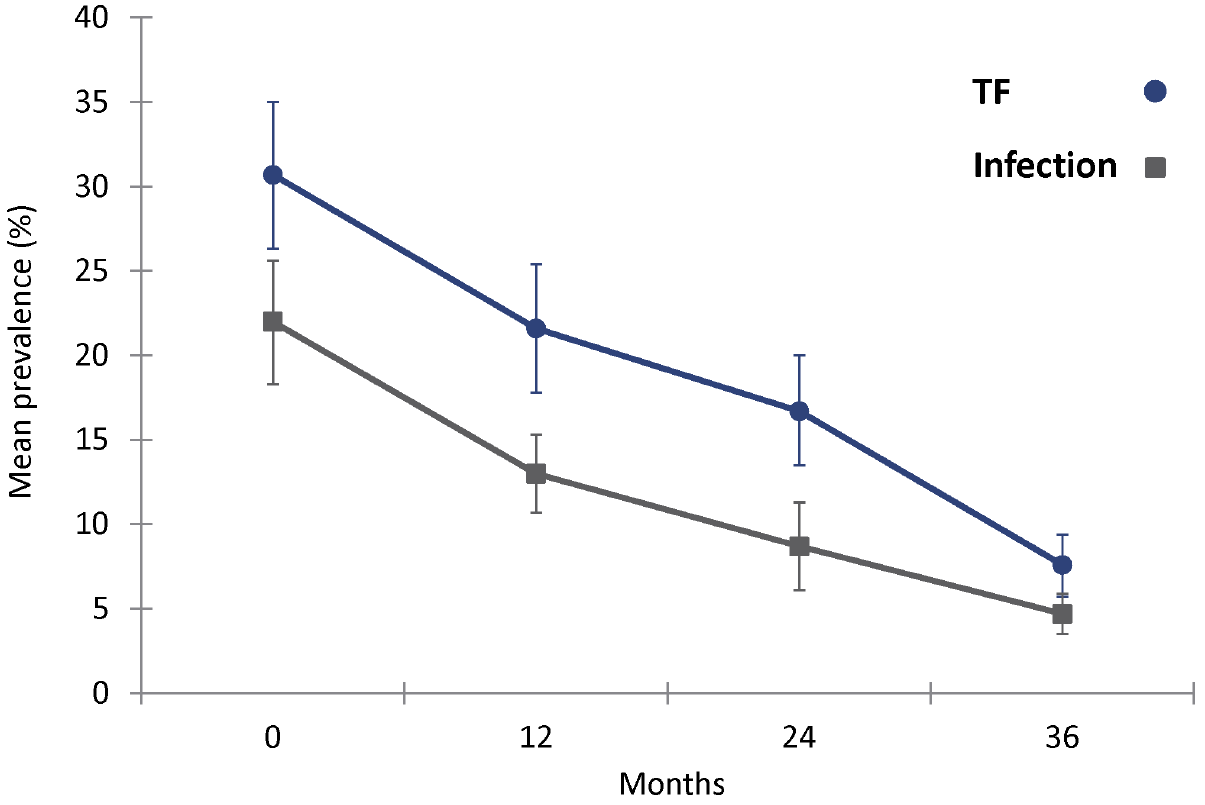
Figure 1. Mean prevalence (and 95% confidence intervals) of C.trachomatis infection and TF in 32 communities over time. doi:10.1371/journal.pntd.0002761.g001 PLOS Neglected Tropical Diseases |